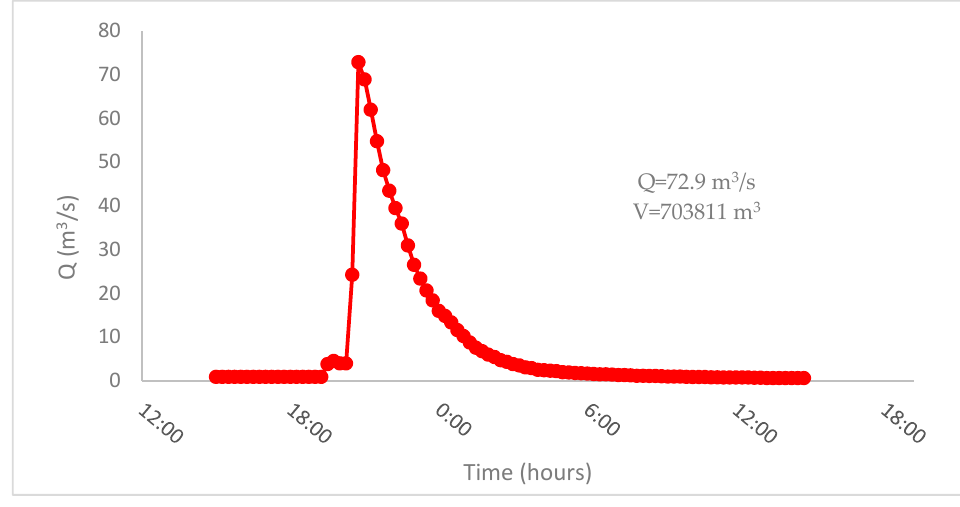
Figure 3. Summer event (11–12 September 2006).